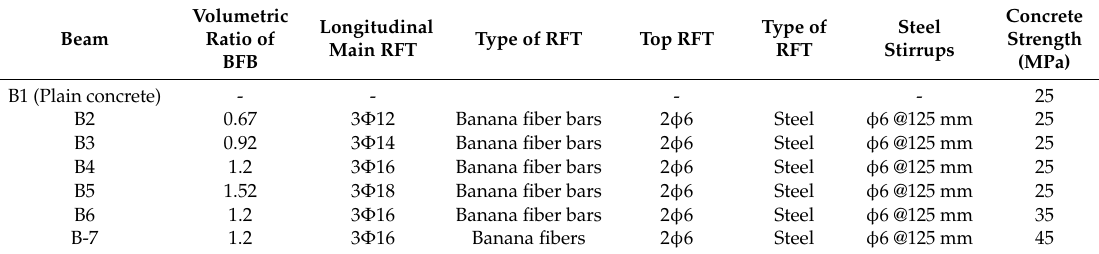
Table 4. Details of the tested beams.